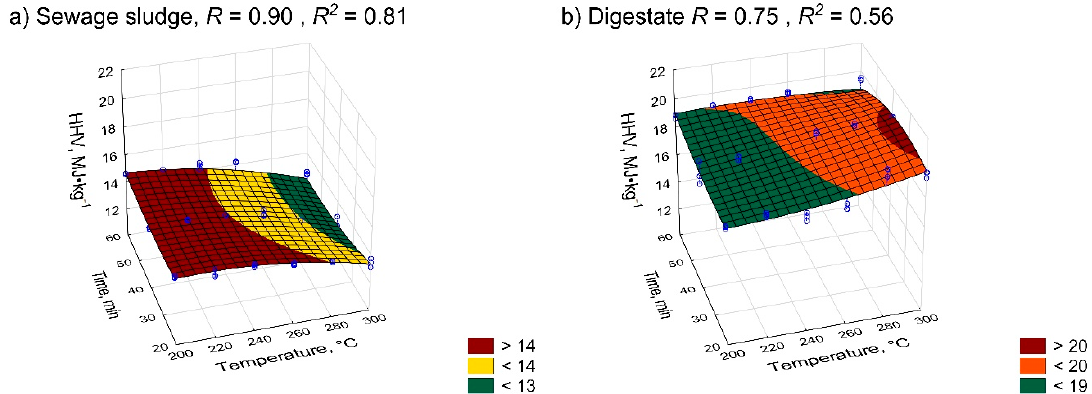
Figure 10. The influence of torrefaction temperature and residence time on the high heating value of CSF from ( a ) sewage sludge and ( b ) digestate. R —correlation coefficient; R 2 —determination coefficient.